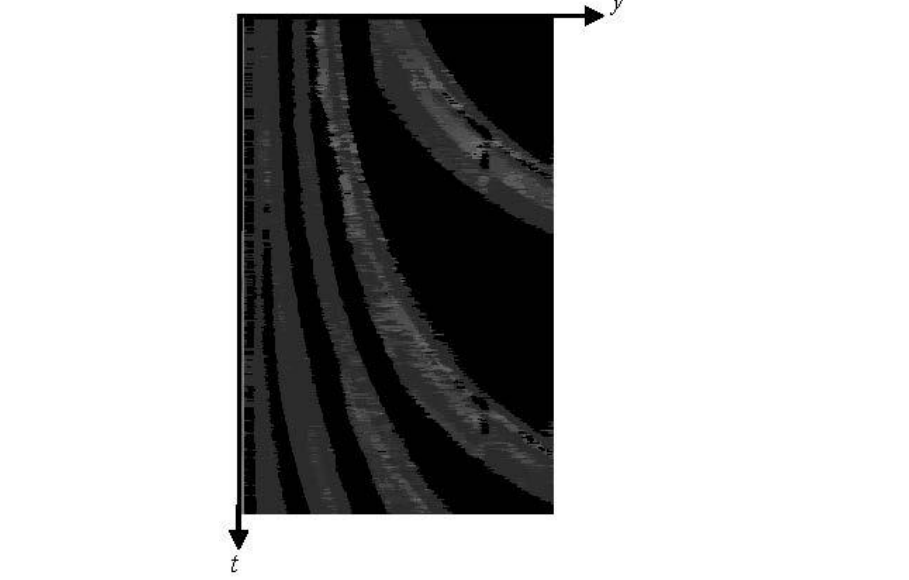
Figure 15. A spatio-temporal image “ST-IMG” with low pixel values